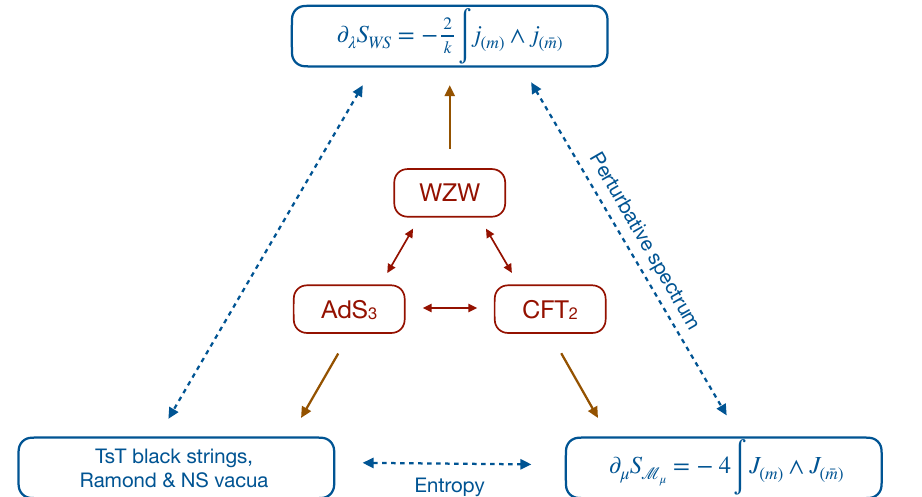
Figure 1. The holographic correspondence between string theory on AdS 3 × M 7 backgrounds and two-dimensional CFTs (inner triangle), and its relationship to the conjectured duality between TsT transformations of AdS 7 spacetimes, bi-current deformations of the worldsheet action, and 3 × M single-trace irrelevant deformations of two-dimensional CFTs (outer